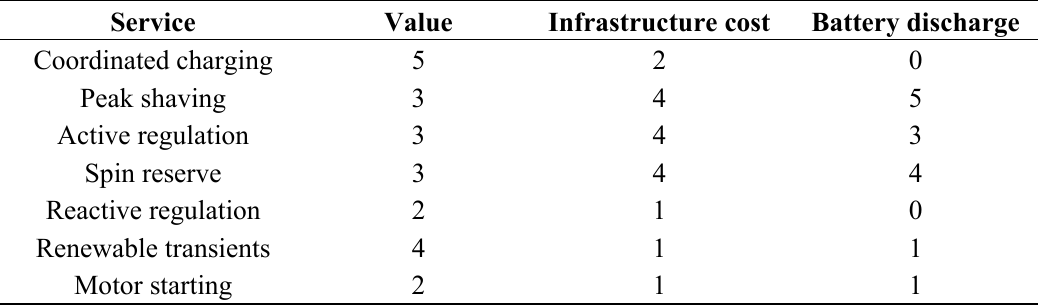
Table 3. Comparison of V2G services (0: lowest–5: